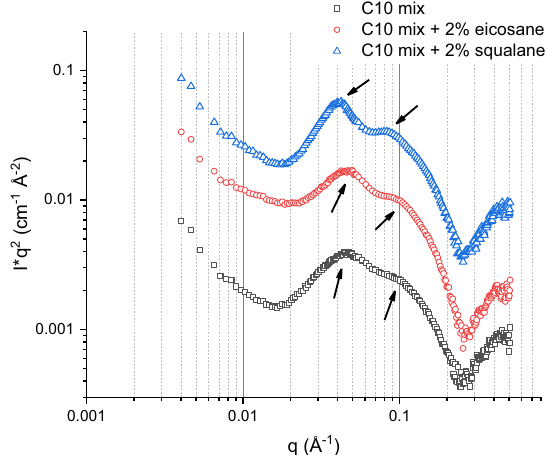
Fig. 7 Fitting the SAXS data. Example of SAXS data fi tting using Gaussian functions with a q − c background. The curves show the SAXS signal from the sample C10 mix + 2% eicosane, T = 20 °C and p = 10, 400, 700, 1000 bar respectively. Arrows show the two fi rst correlation orders, proving the membrane lamellar ordering (together with the data shown in Fig. 6). The white lines are fi ts to the data. Inset: zoom in the mid-wide q -range. All related fi tting parameters, errors and resulting χ 2 can be found in the Supplementary Information (Supplementary Table 1, see also Supplementary Note 2 and Supplementary Fig.